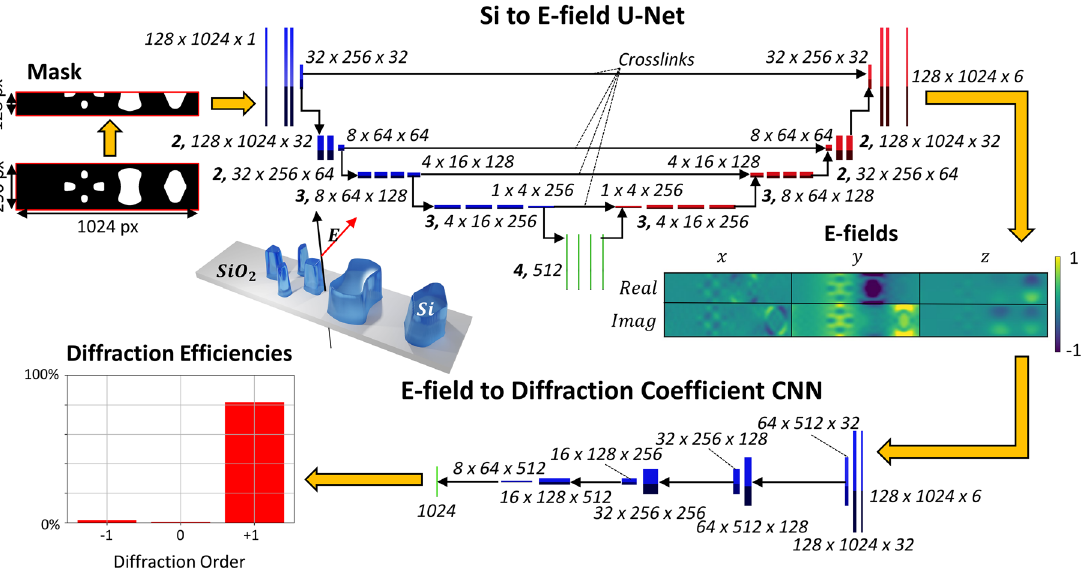
Figure2: Diagramof networktopology,composedof twosubnetworks.The firstsubnetwork(top) convertsa binarysupercellmaskto electric fieldsviaaU-Net.CrosslinksfromtheU-nethelpensurethatthegeometryofthestructureispreservedintheE-fields.Thesecondsubnetwork (bottom) converts electric fields to diffraction coefficients using a standard multi-layered CNN. Both subnetworks exploit mirror/anti-mirror y -symmetry of the mask and fi elds to cut the size of the network by half. Each layer or set of layers is labeled to show its shape: y-pixels by x- pixels by # of features